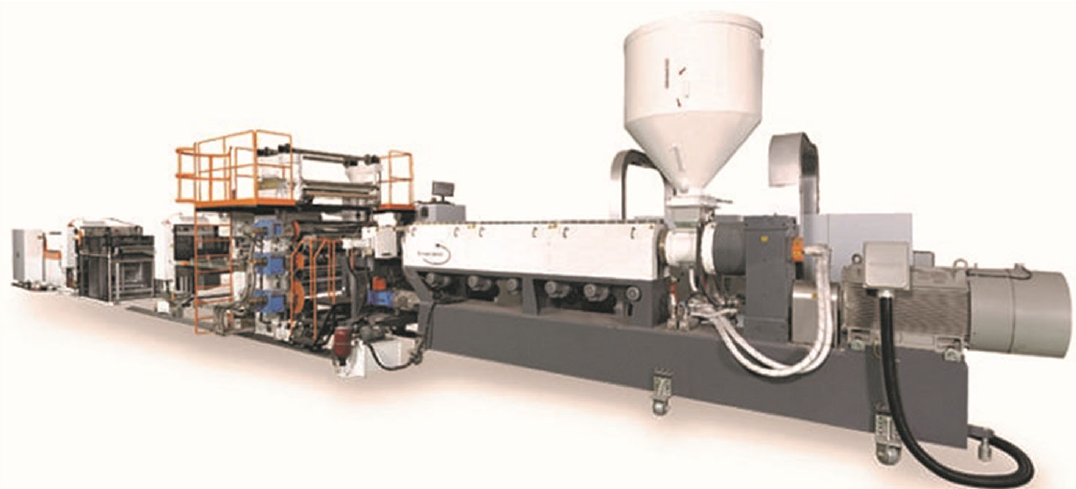
Figure 3. Full ‐ automatic polypropylene extrusion line (Reprinted with permission from Ref. [32]. Copyright 2022, Sunwell Global).